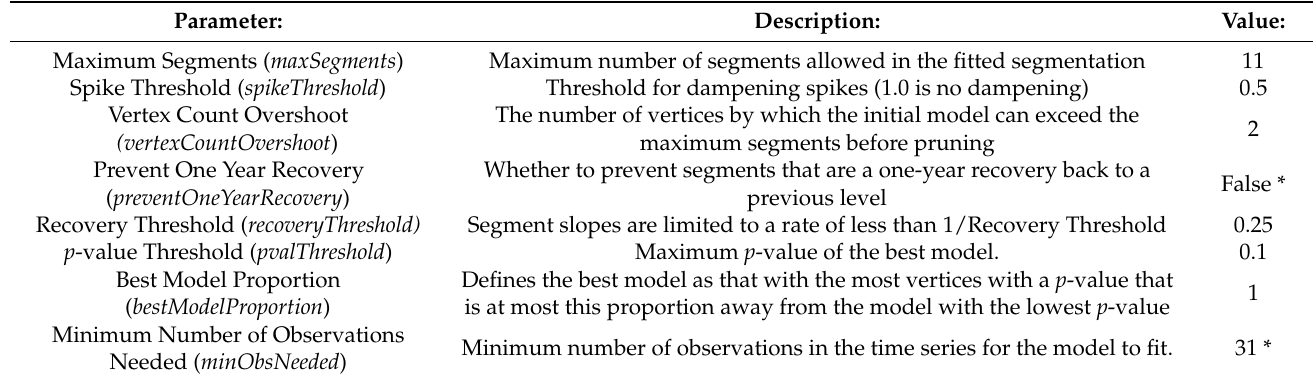
Parameter settings used for fitting LandTrendr (originally described by Kennedy et al. [26,27,33]. These settings were found to minimize omission of previously-identified surface water compared to the NWI. Values marked with an asterisk were not systematically varied to find the optimal setting, but were accepted at this value a priori based on the expected behavior of the system or performance of the